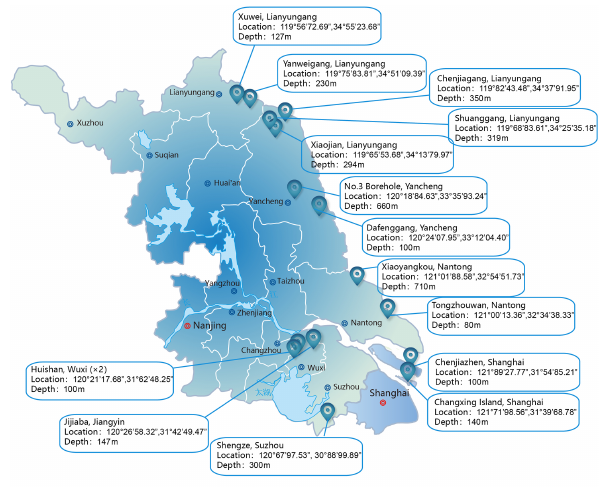
Figure 2. The locations of land subsidence monitoring boreholes using DFOS in Jiangsu and